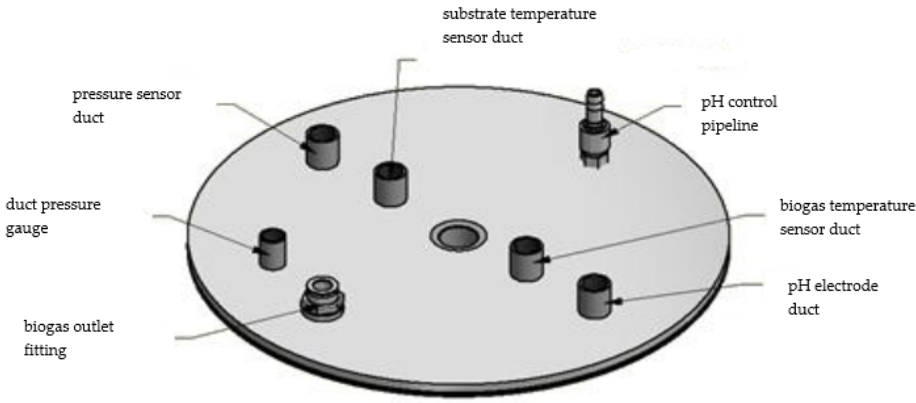
Figure 5. Hermetic lid for the fermentation chamber [9].